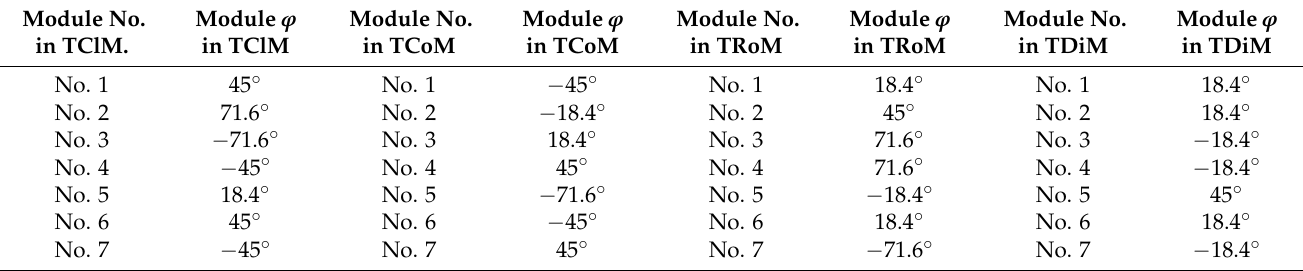
Table 1. The heat-flow transfer inclined angles, denoted as ϕ , of the square unit modules in the ther- mal cloak (TClM), thermal concentration (TCoM), thermal rotation (TRoM), and thermal dispersion (TDiM) meta-structures sketched in Figure